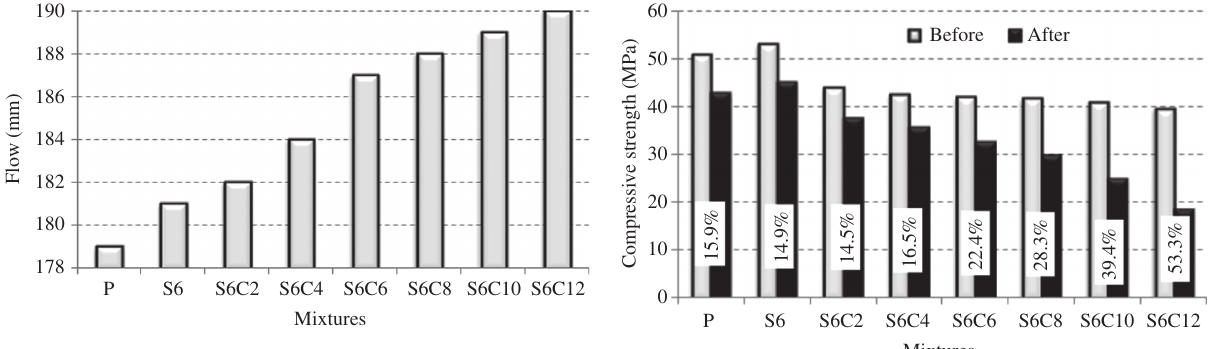
Figure 6 Expansions of mixtures.